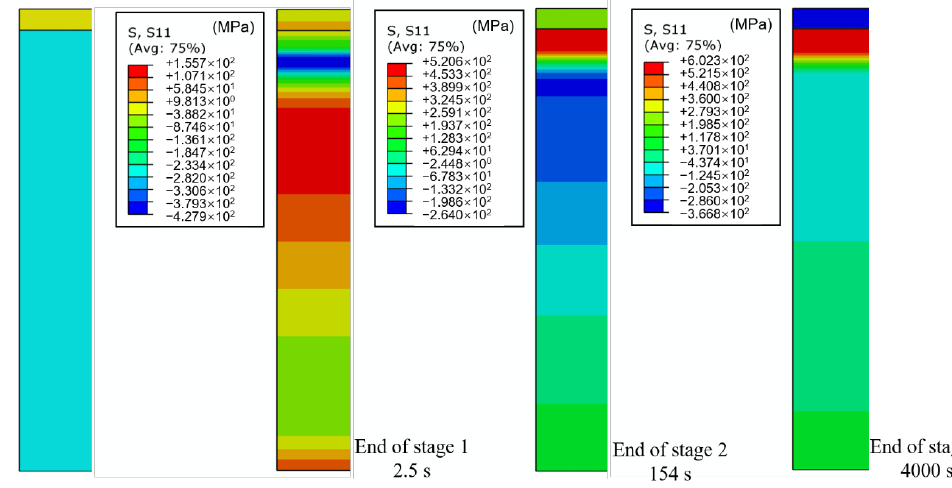
Figure 15. WRS nephogram at the ends of different stages.